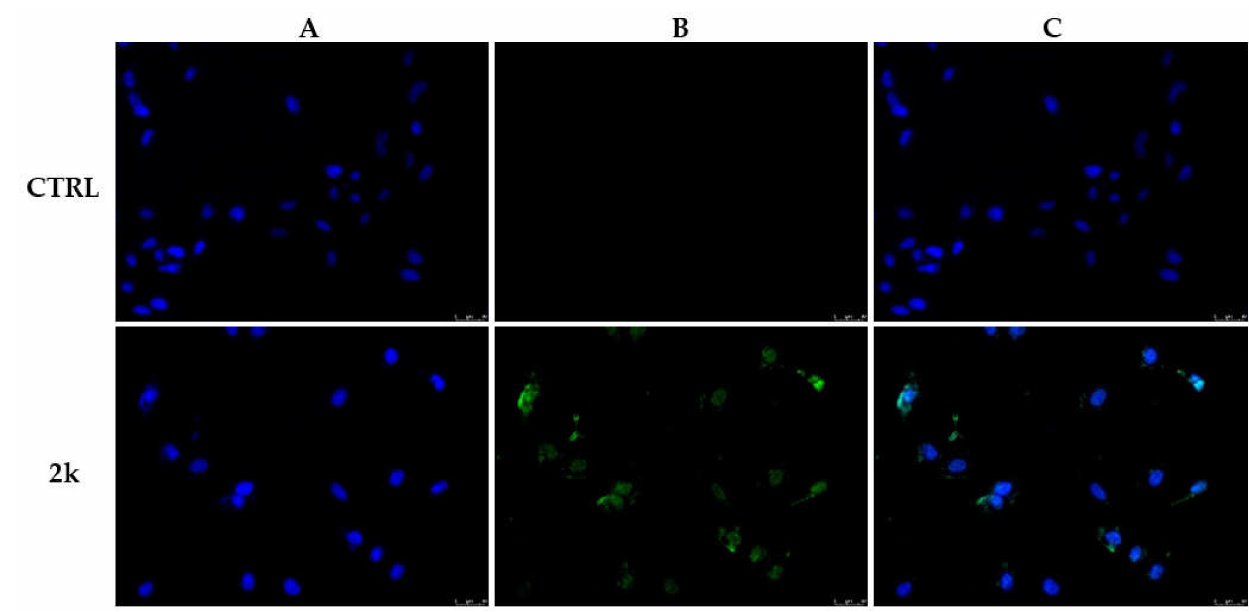
Figure 4. TUNEL assay. A2058 cells were treated with compound 2k used at its IC 50 value or with the vehicle (CTRL) for 24 h. Apoptotic death is clearly indicated by the green nuclear fluorescence, present in the A2058 cells treated with compound 2k and absent in the CTRL cells. Images were acquired under an inverted fluorescence microscope at 20 × magnification. ( A ) DAPI (CTRL and compound 2k ) λ ex = 350 nm/ λ em = 460 nm. ( B ) CF™488A (CTRL and compound 2k ) λ ex = 490 nm/ λ em = 515 nm. ( C ) Overlay channel. Fields are representative of three separate